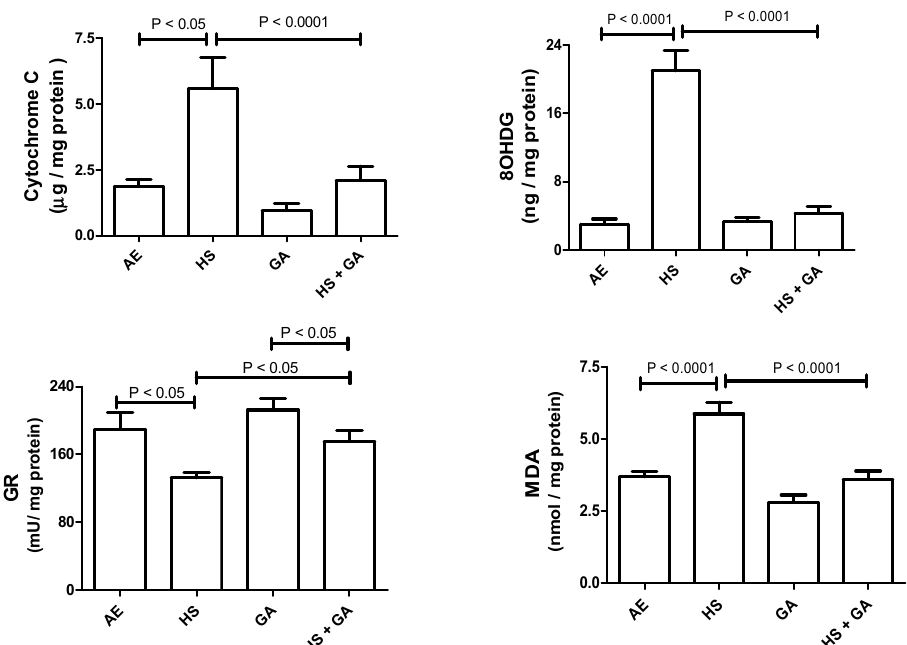
Figure 3. The testicular homogenate concentrations of cytochrome C, 8-oxo-2 ′ -deoxyguanosine (8-OHdG), glutathione reductase (GR), and malondialdehyde (MDA) in mice exposed to normal air (AE) and hookah smoke (HS, 30 min / day) or treated with gum acacia (GA, 15% w / v ) with or without exposure to HS. Each vertical column with bar represents the mean ± SEM ( n = 8). A p < 0.05 was considered significant.